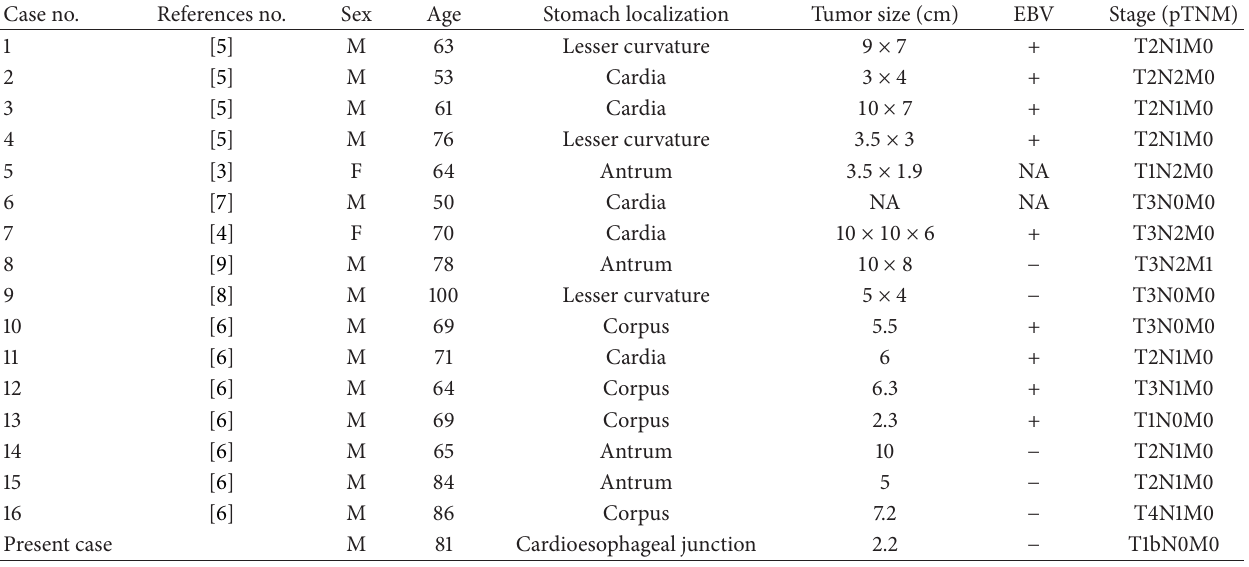
Table 1: Clinicopathologic characteristics of all reported cases of gastric adenocarcinoma with OGCs. Case